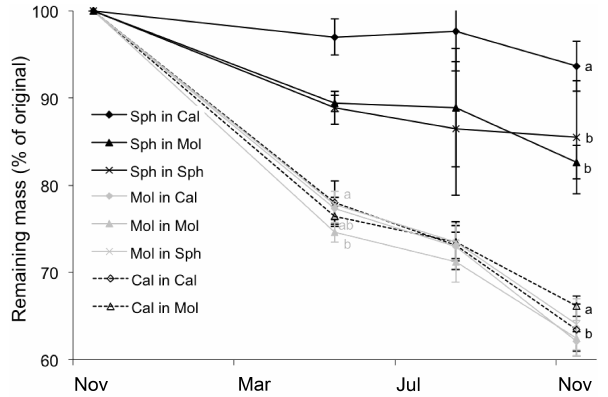
Figure 3. Residual mass in the litterbags as a function of time for different combinations of litter and vegetation cover. “Cal in Cal” means Calluna litter decomposing under Calluna , “Cal in Mol” means Calluna litter decomposing under Molinia , and so on. Er- ror bars are standard deviations, while lower-case letters indicate significant differences ( p < 0.05) between same litters decompos- ing under different types of vegetation. The trial was 1 year